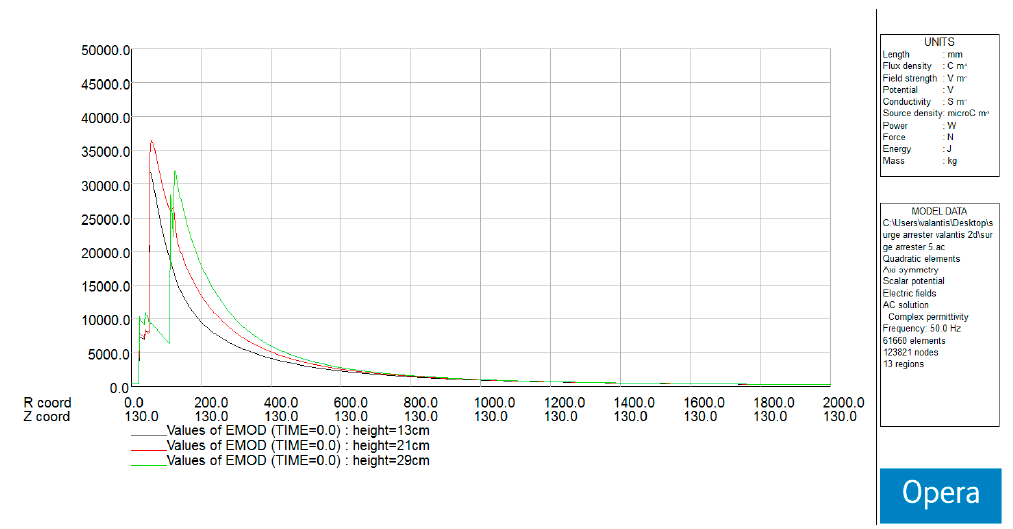
Figure 13. Electric field distribution around the arrester under study in the case of a broken shed (2D PC Opera).